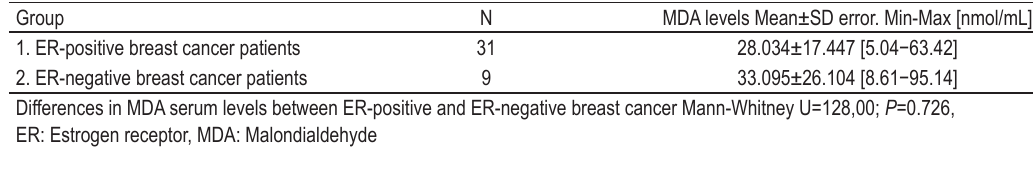
TABLE 5. MDA serum levels in breast cancer patients regarding menopausal status Group N